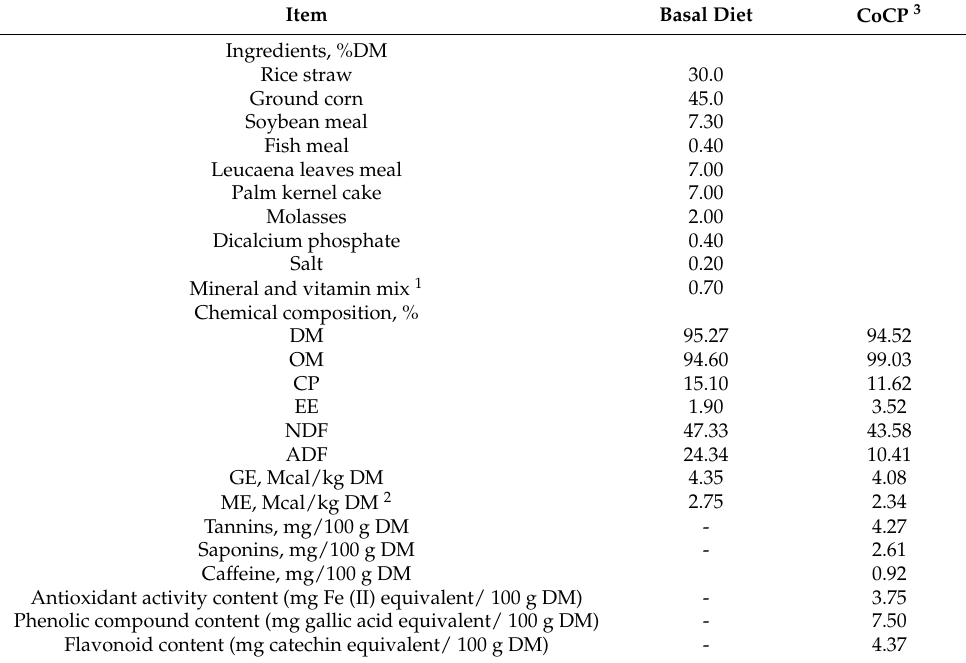
Table 1. Ingredients and chemical compositions used in the experiment: TMR basal diet and coffee cherry pulp